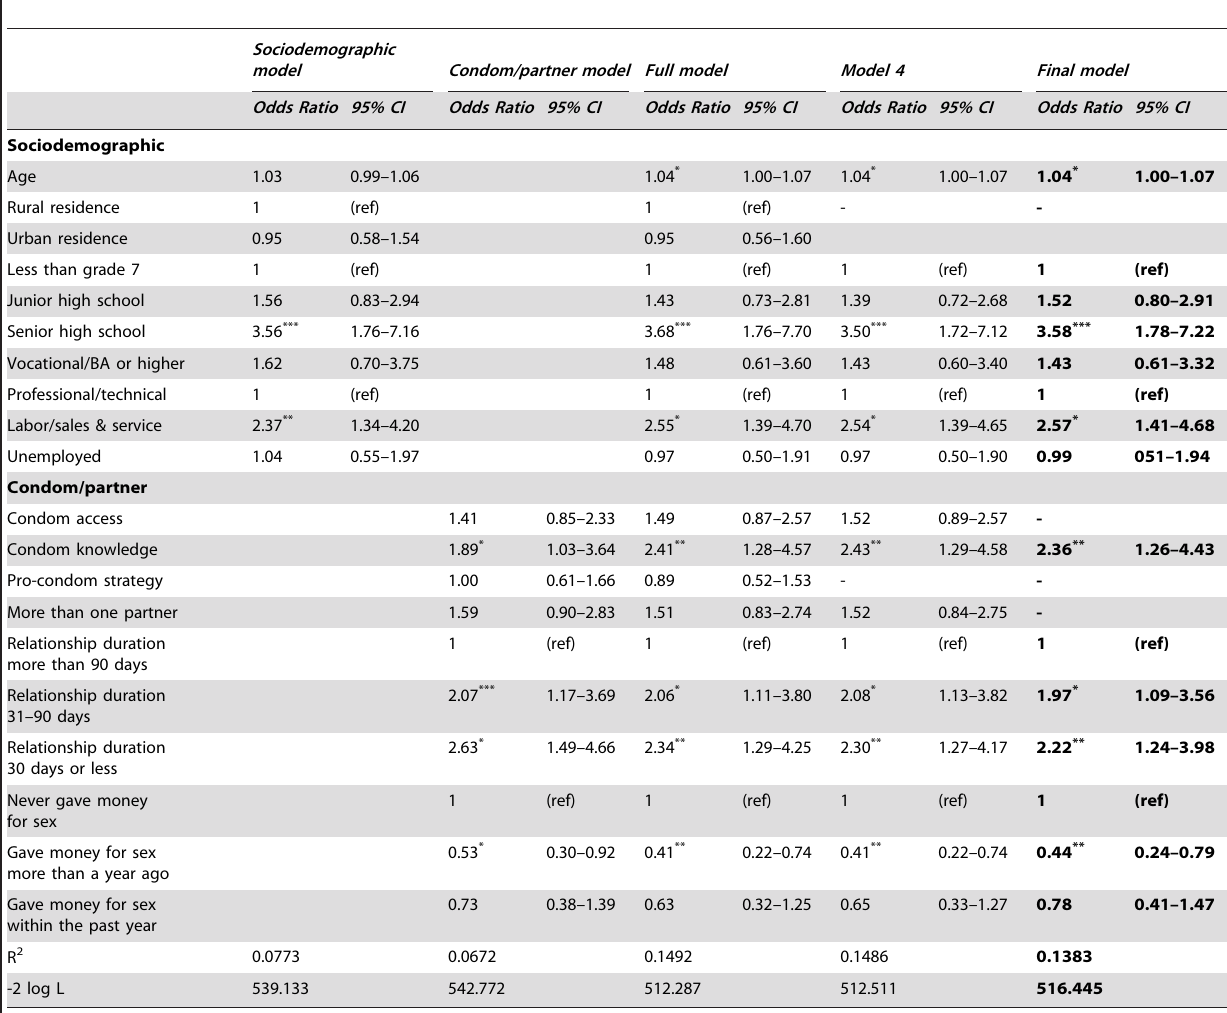
Table 5. Building the final proportional odds regression model to predict higher levels of condom use for men with casual partners in the 2006 National Sexual Behavior Survey of Thailand (N=